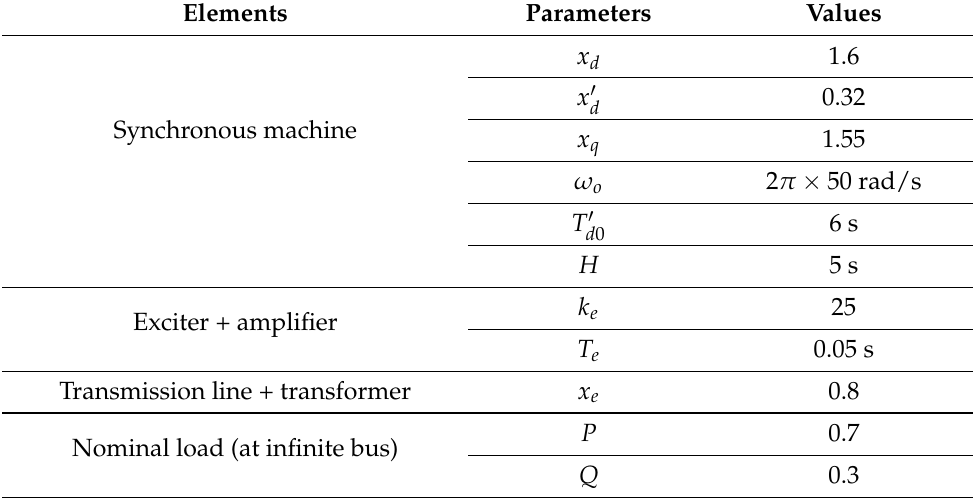
Table 1. Considered values of parameters for SMIB.